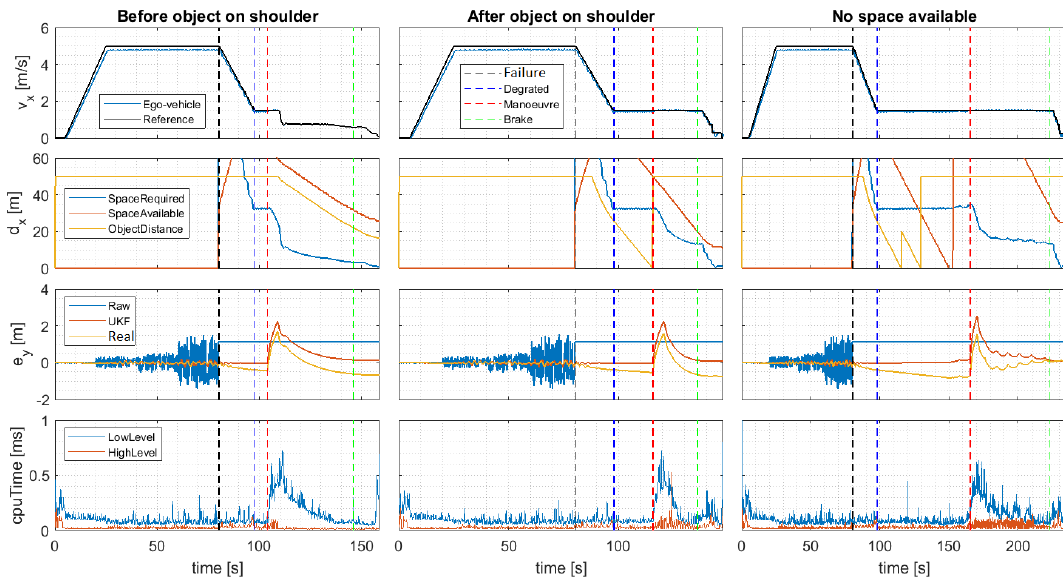
Figure 11. DDT fall-back response due GNSS total failure after continuously degrading